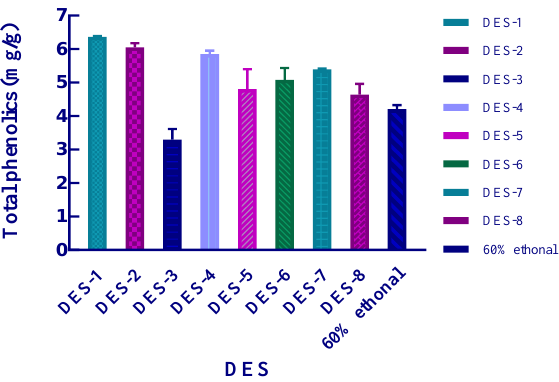
Figure 2. Effects of different DES on the extraction yield of polyphenols in S. baumii . The results of the single factor test are shown in Figure 3. The experimental results show that when the water content was 40%, the yield of the extracted polyphenols reached the maximum, shown in Figure 3A. When the extraction time was 40 min, the polyphenols yield was not significantly different from that obtained using an extraction time of 50 min. From the view of energy and cost savings, 40 min was selected as the optimal extraction time of S. baumii polyphenols, shown in Figure 3B. The polyphenols yield was the highest at 60 °C, shown in Figure 3C. The polyphenols yield was the highest at a ratio of 40 mg/mL, shown in Figure